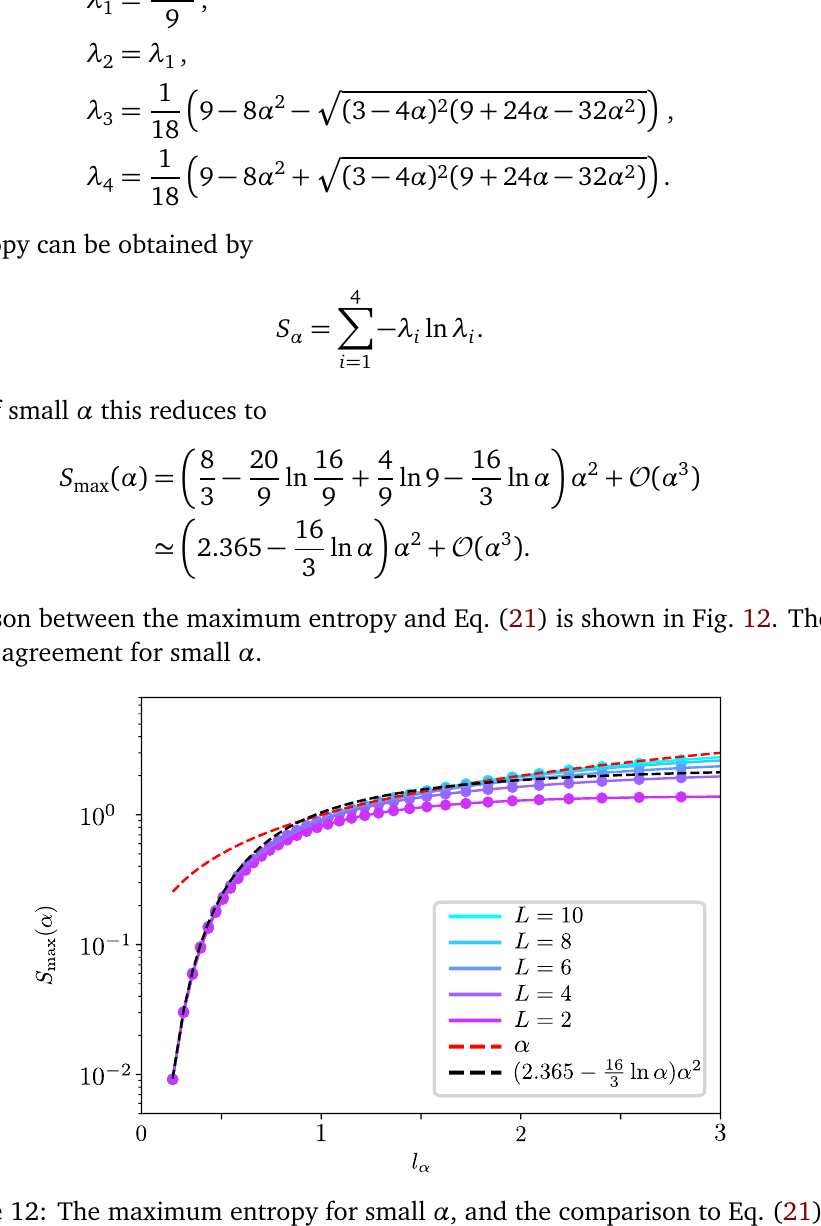
Figure 12: The maximum entropy for small α , and the comparison to Eq.